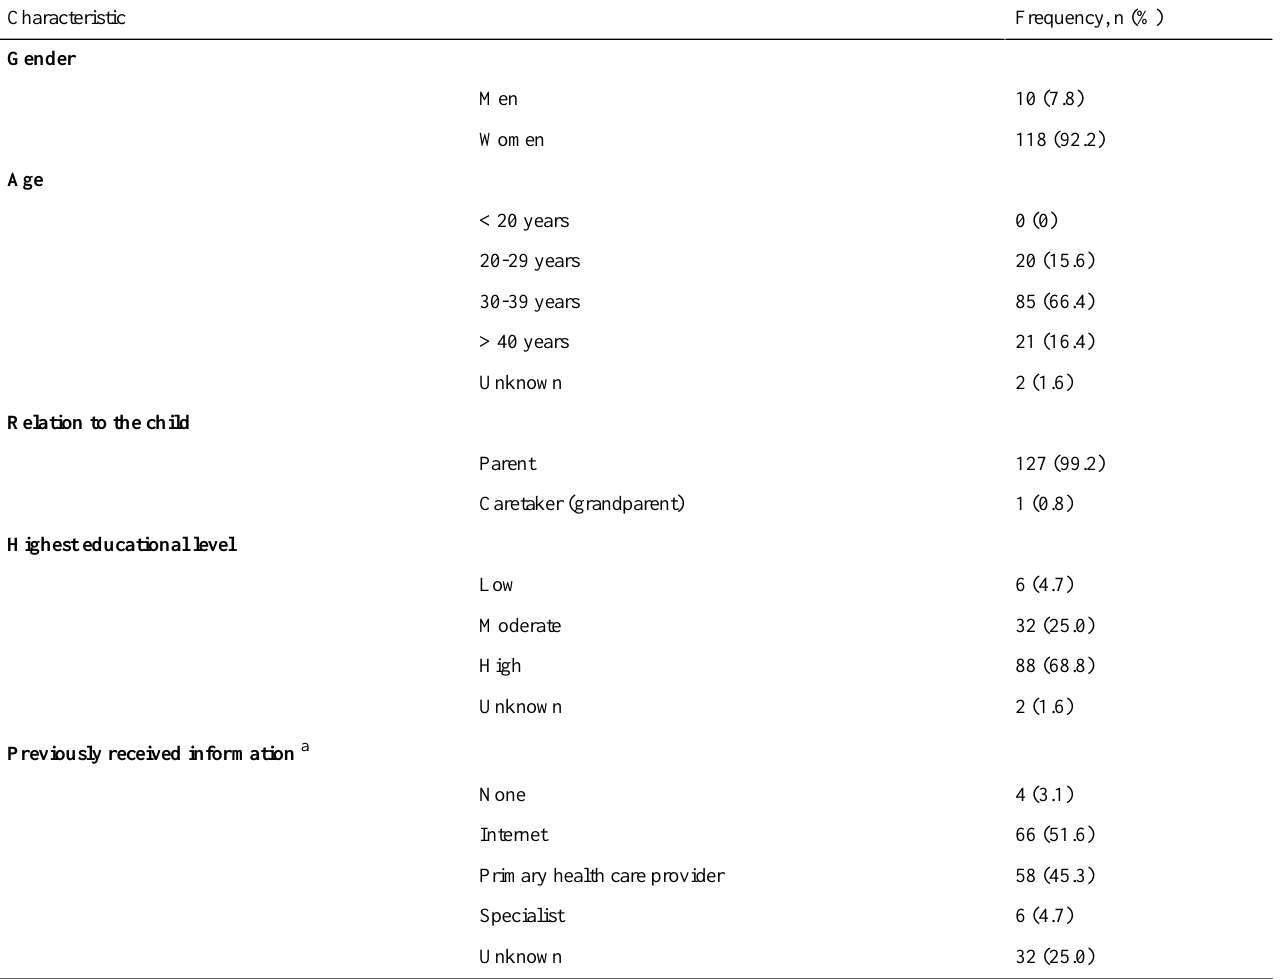
Table 2. Characteristics of the parents